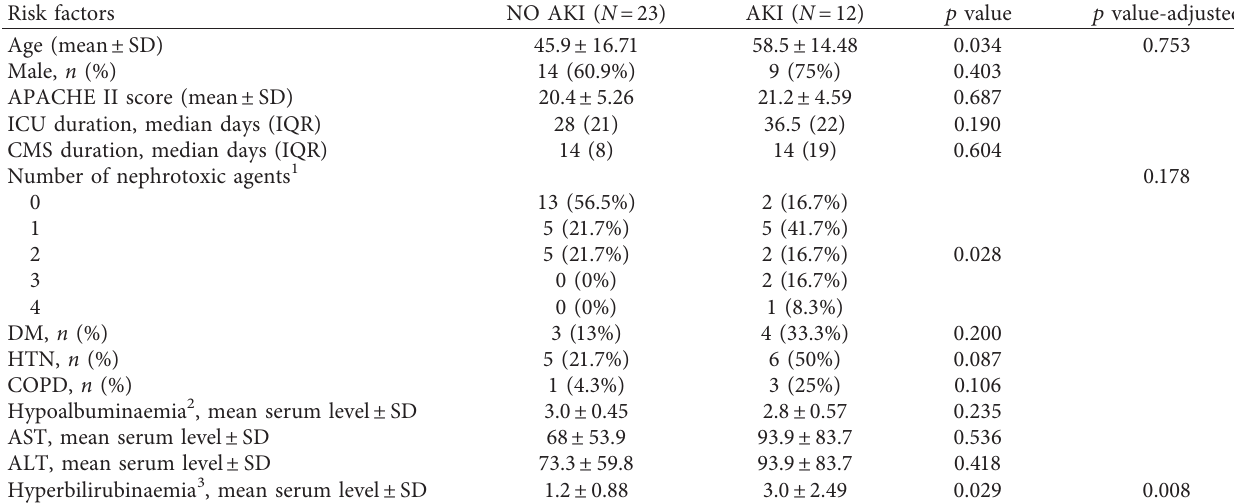
Table 3: Risk factors for the development of nephrotoxicity during CMS therapy.